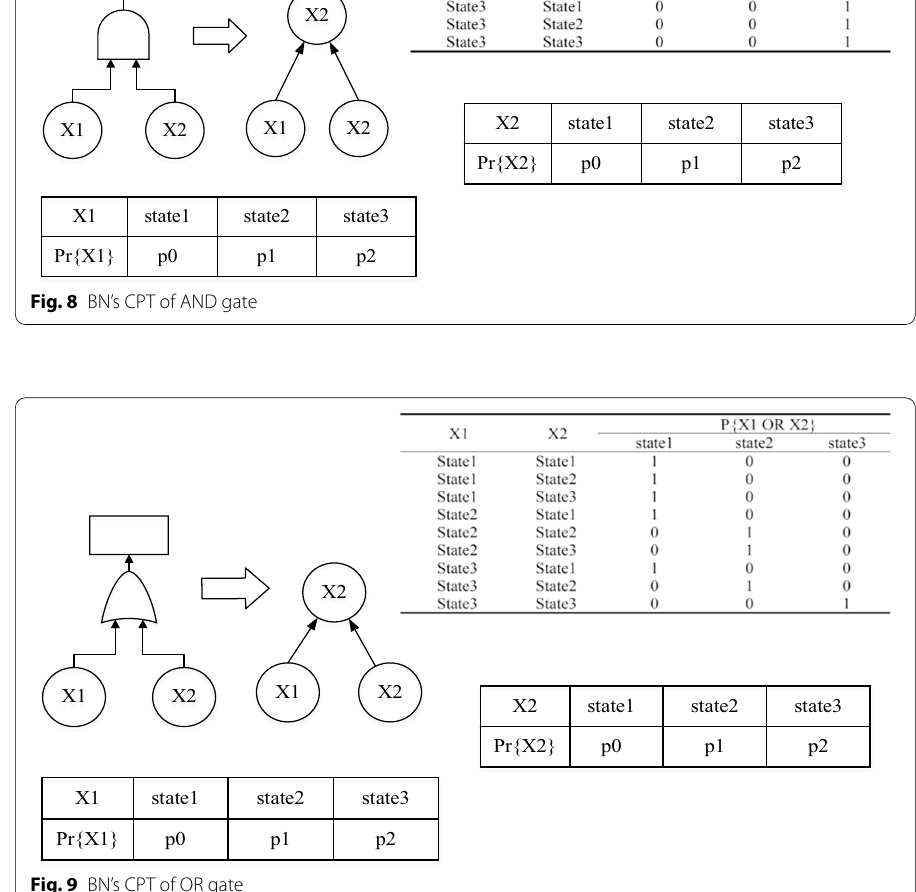
Fig. 9 BN’s CPT of OR